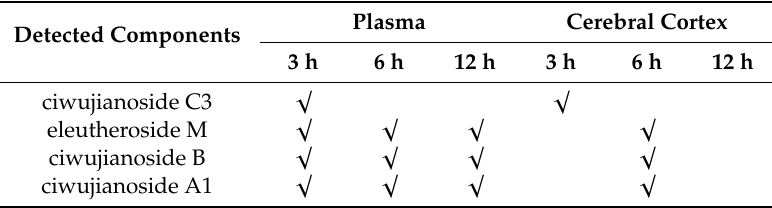
Figure 5. Ciwujianoside A1 was detected in plasma and the cerebral cortex after oral administration of the leaf extract of E. senticosus. A structure of ciwujianoside A1 and LC-MS charts of plasma ( A ) and cerebral cortex ( B ) from vehicle-treated and leaf extract-treated mice 6 h administration of the extract. Red arrows indicate a peak ciwujianoside A1. A blue value means intensities of the peak. Table 1. Summary of the detected compounds in the plasma and the cerebral cortex of mice after oral administration of the leaf extract of E. senticosus .